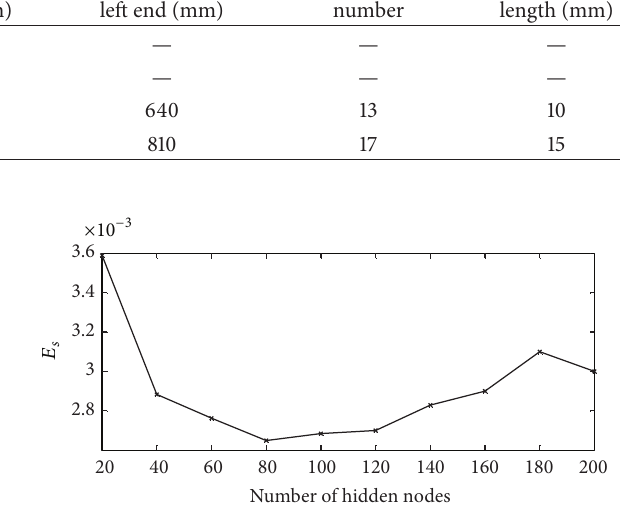
Figure 12: Validation performance as a function of the number of hidden